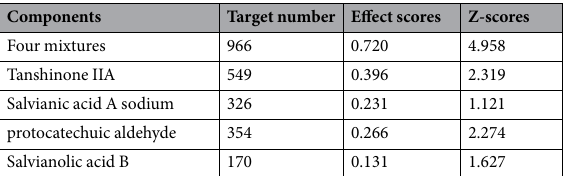
Table 4. Effect scores and Z-scores of four mixtures and its single component to cardiovascular disease.